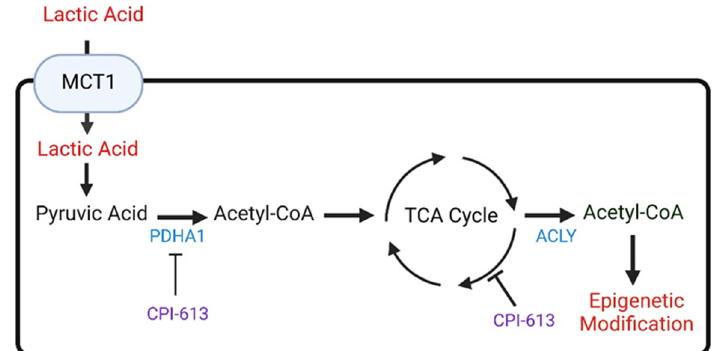
Figure 3. Lactic acid is a substrate of the TCA-cycle and involved in acetyl-CoA production. GBM cells take up lactic acid through the membranous transporter MCT1 and convert it to pyruvic acid. Pyruvic acid is subjected to oxidative decarboxylation by PDHA1, resulting in the release of CO 2 and production of acetyl-CoA. Acetyl-CoA is converted into citrate in the TCA cycle and released to the cytosol. The ACLY reaction produces acetyl-CoA that in turn serves as a substrate for histone acetyltransferases that modify histone H3 and H4, resulting in enhanced accessibility of chromatin and transcription of genes facilitating proliferation. CPI613 interferes with lactate metabolism by blocking PDHA and interference with the TCA-cycle. The image is adapted from [23].